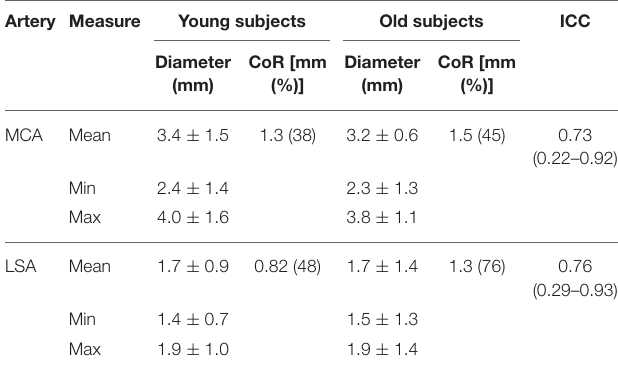
TABLE 2 | Flow, pulsatility index and damping factor and reproducibility of their mean